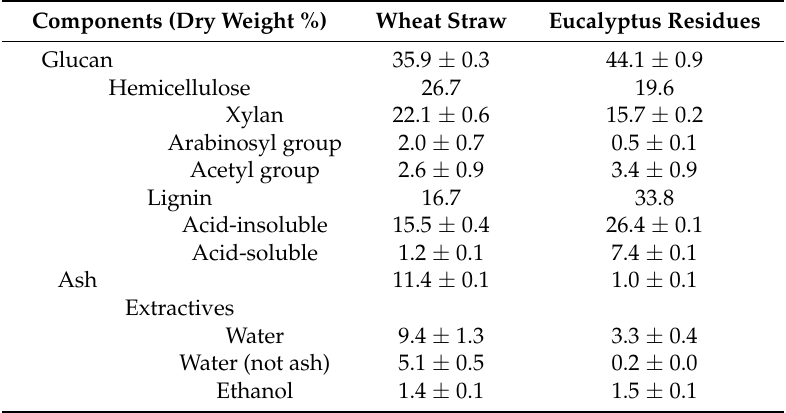
Table 1. Wheat straw and eucalyptus residues macromolecular